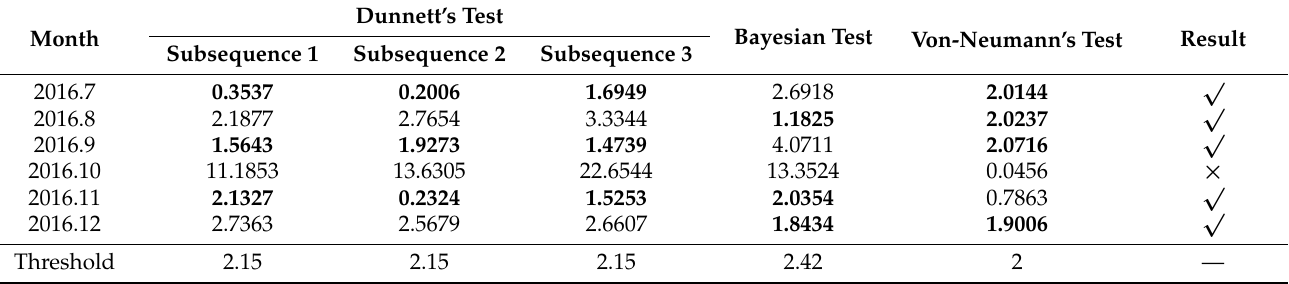
Table 5. Results of homogeneity